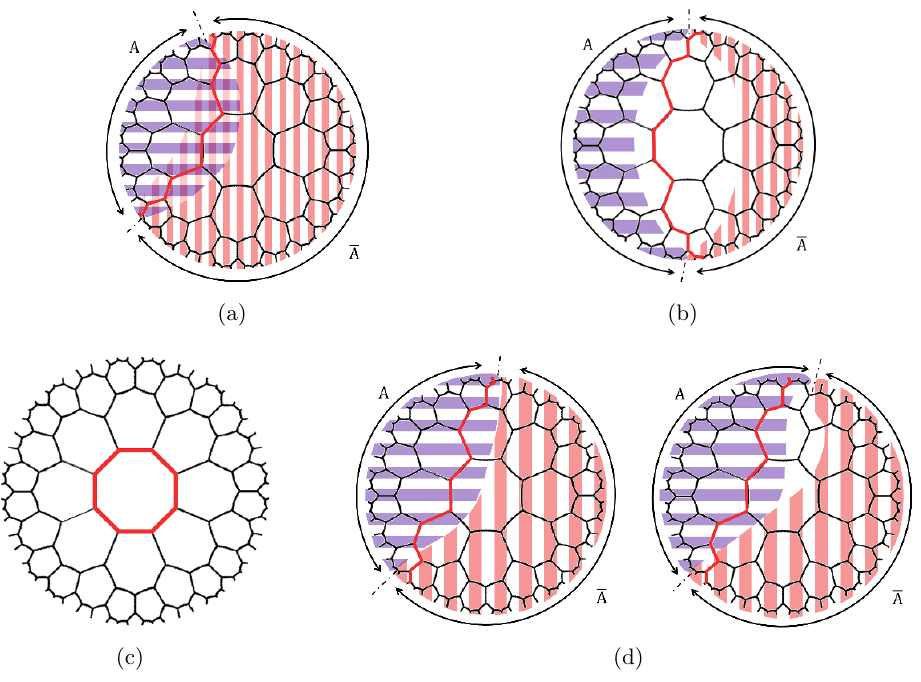
Figure 31 . The tensor network with f 7 ; 3 g tiling in the UV and f 8 ; 3 g tiling in the IR. The sets of tensor constraints are (a) S c =